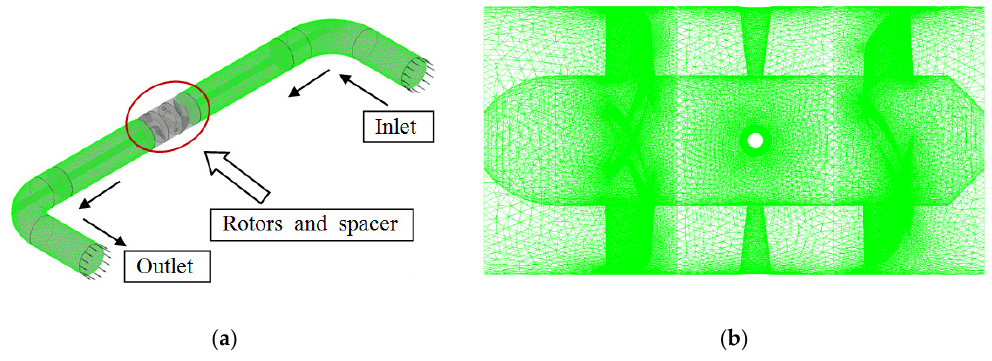
Figure 3. The numerical simulation model of contra-rotating small hydro-turbine: ( a ) Numerical grids of the whole domains; ( b ) Mesh data of test turbine, the flow direction is from left to right.